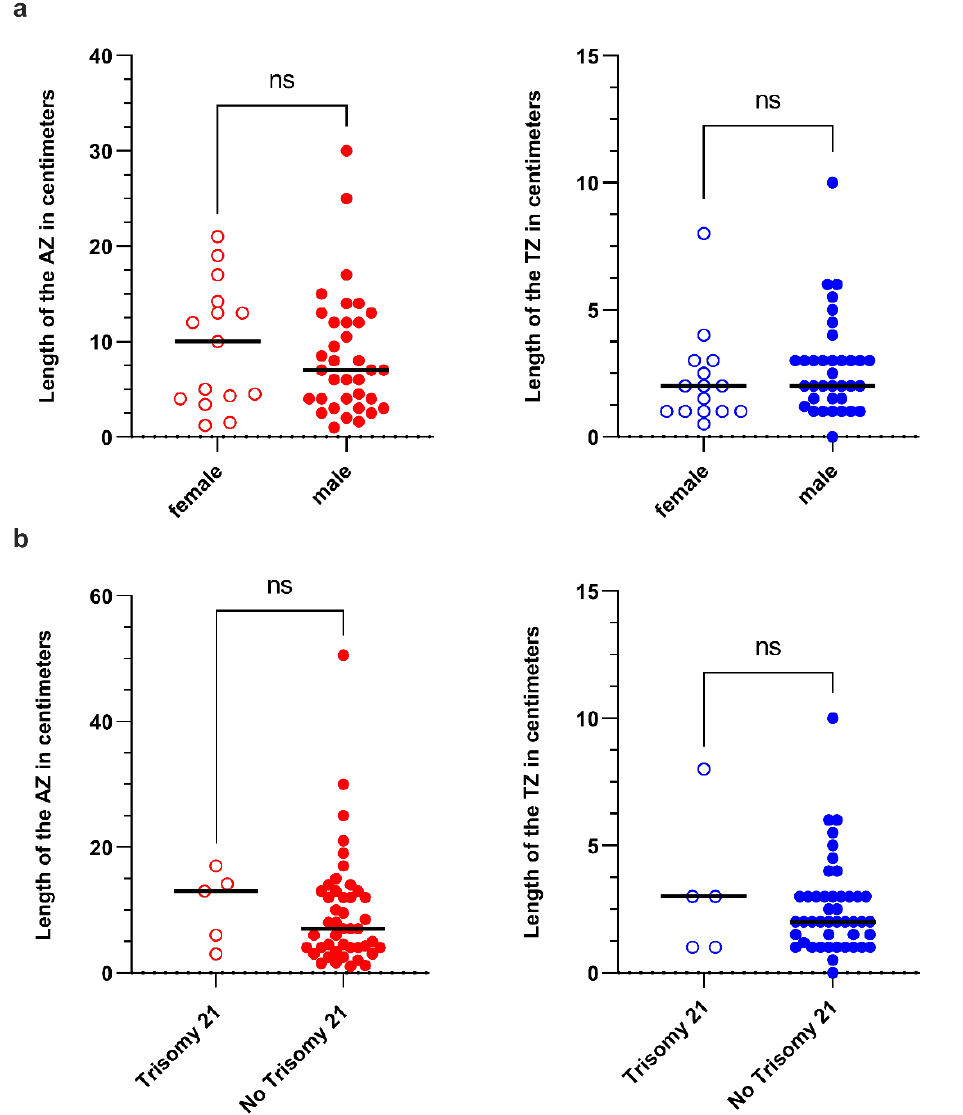
Figure 5. Analysis of the segment length of the AZ ( left ) and TZ ( right ) in centimetres in all patients regarding ( a ) gender and ( b ) presence or absence of Trisomy 21 revealed no significant difference between the groups.